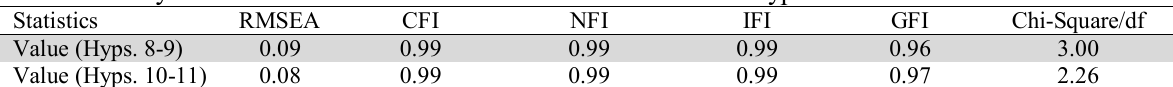
The summary of statistical observation associated with the 8-11 th hypotheses Statistics RMSEA CFI